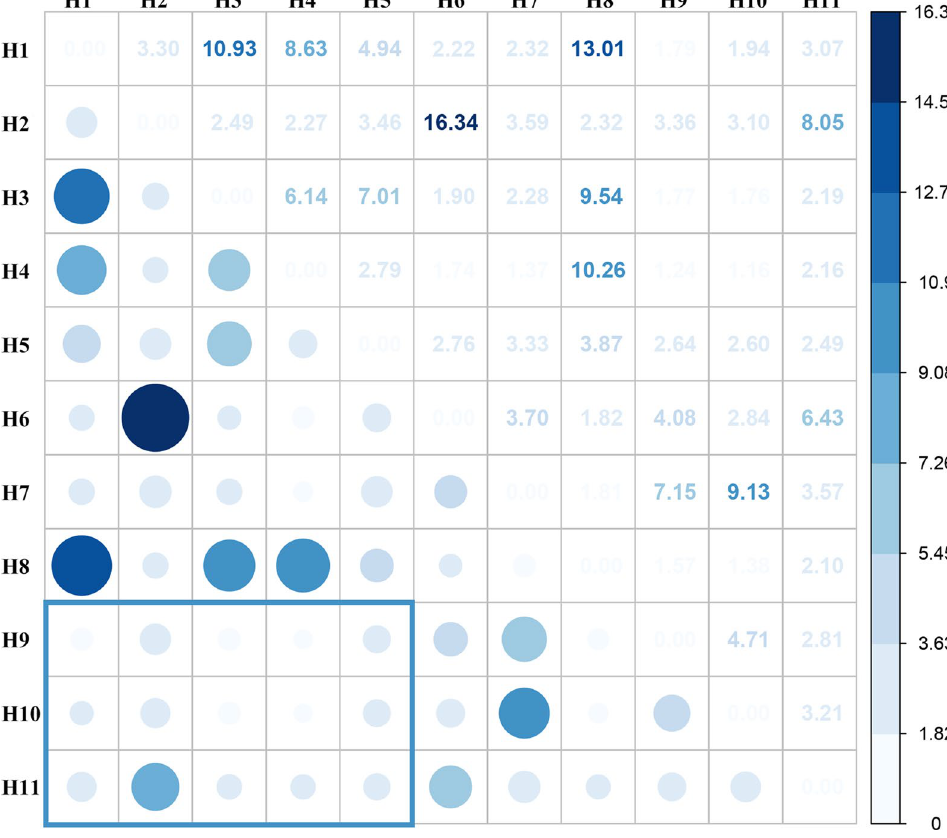
Fig. 3 Pairwise population Nm values indicate frequent migrations of Pt strains between geographically close populations. The shade of the color and size of the circle represents the Nm values. Populations in long distances have low Nm values in the bottom left box (H1–H5 with